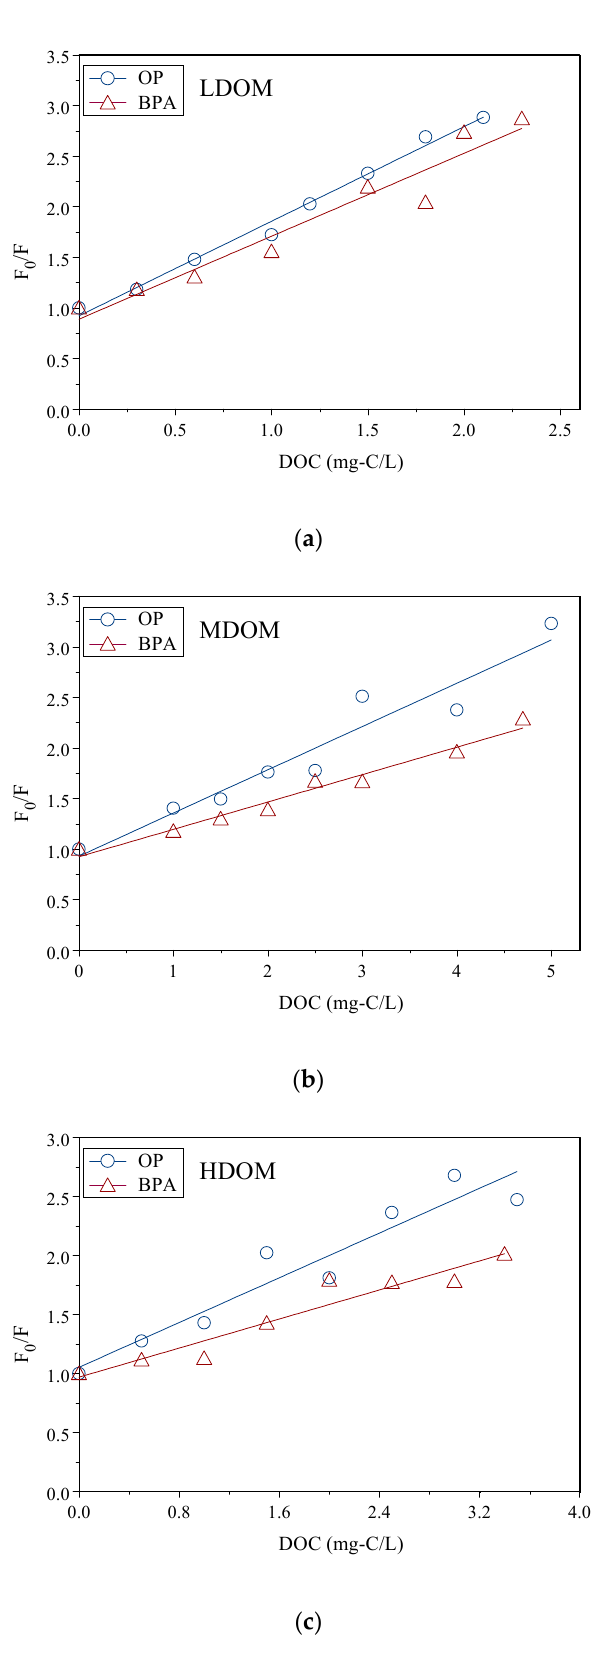
Figure 2. The linear regression between ratios of F 0 /F for OP/BPA and DOC concentrations of size-fractioned DOM: LDOM ( a ), MDOM ( b ), and HDOM ( c ).